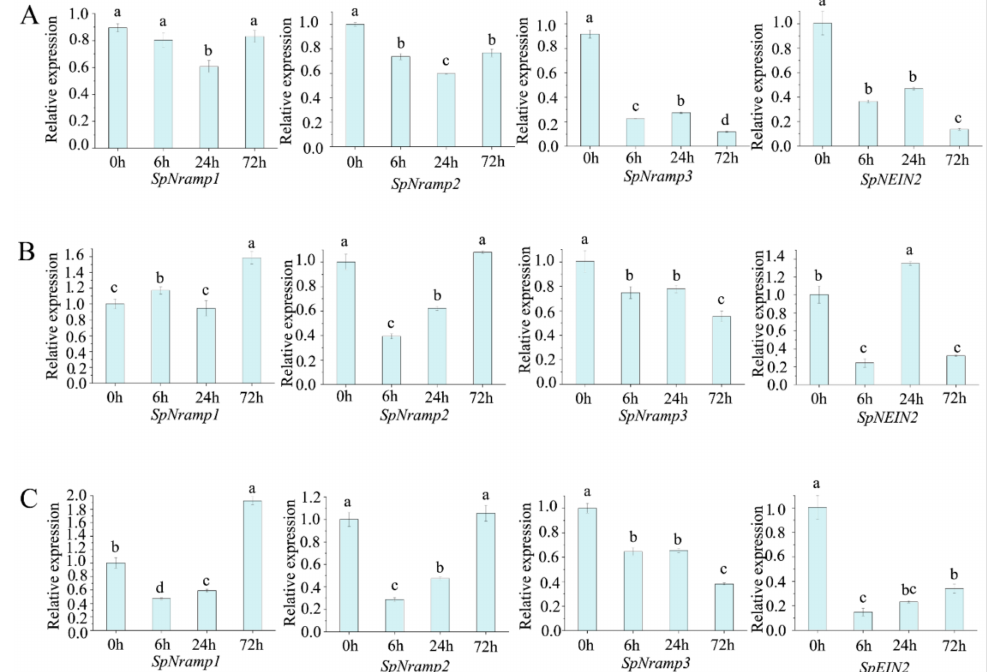
Figure 7. Expression patterns of four SpNramp genes under three abiotic stress. Quantitative RT-PCR was used to analyze the expression levels of each SpNramp gene. The X-axis represents the RNA samples from S. polyrhiza under different treatments at different time points (0, 6, 24, and 72 h). The Y-axis represents the relative expression levels of SpNramp genes by 2 − ∆∆ Ct method. ( A ) is treated by 50 µ M Cd 2+ . ( B , C ) contains 50 µ M Cd 2+ under Fe 2+ or Mn 2+ deficiency, respectively. The Actin (ACT) gene was used as an internal control. The 2 − ∆∆ Ct was carried out to calculate the SpNramp genes’ relative expression. Different letters represent significant differences as determined by Duncan’s multiple range test ( p ≤ 0.05). Error bars, mean ±